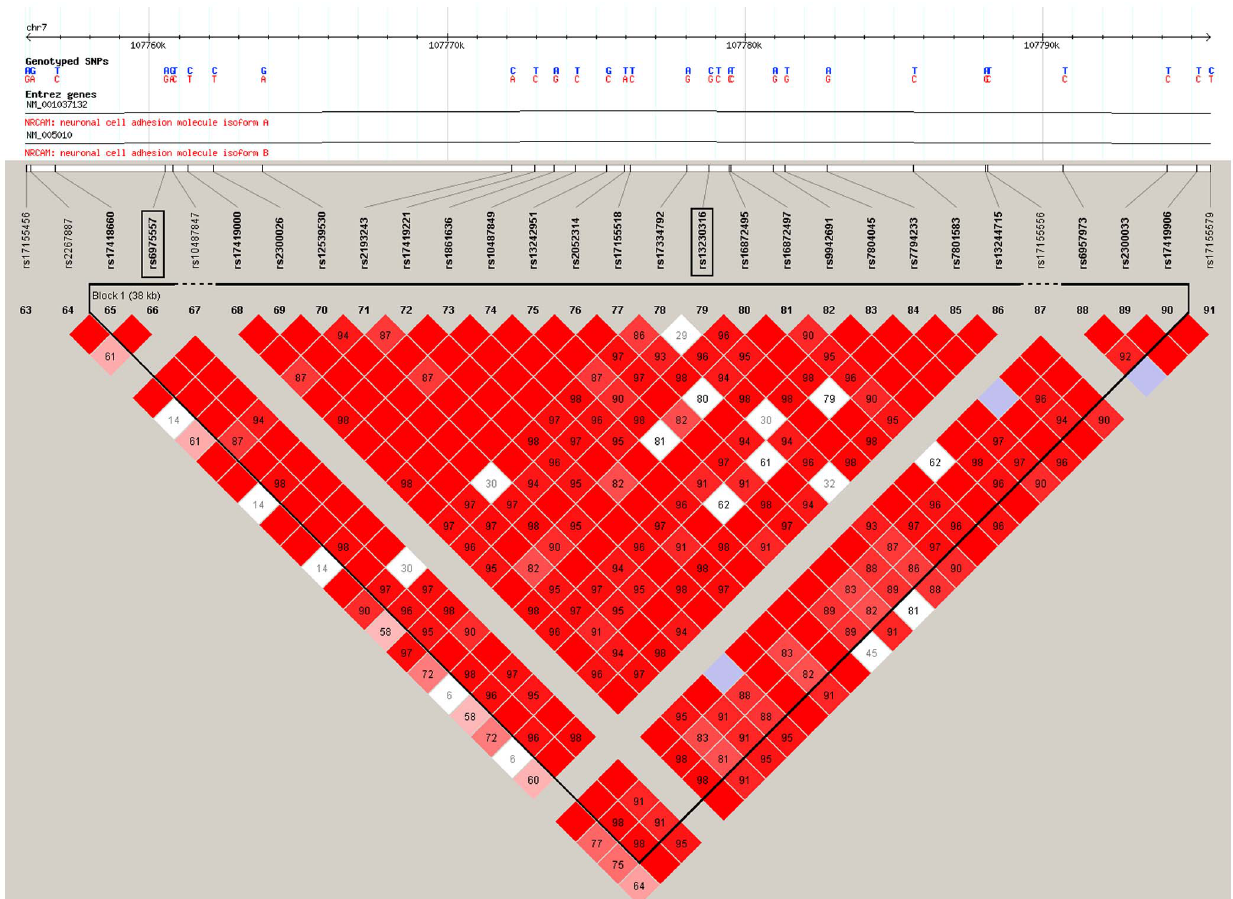
Figure 2. LD structure of the NRCAM gene in the discovery Caucasian sample. The region demarcated in red indicates that r 2 . 0.9. The region includes only one LD block as indicated by triangle with black lines. SNP rs6975557 and rs13230316 are located within one block.